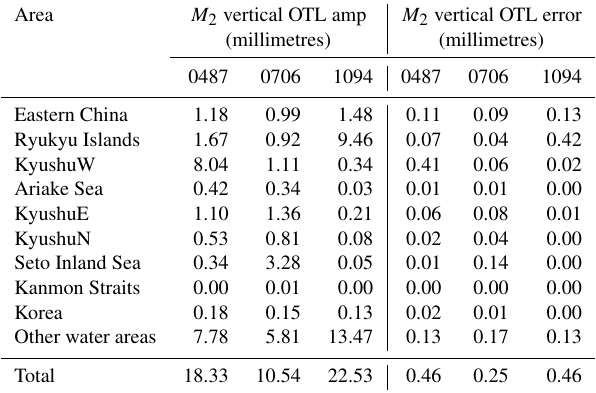
Table 3. The contribution of the defined water subareas in Fig. 2 to the M 2 vertical OTL displacement amplitudes and the resulting errors at GPS sites 0487, 0706, and 1094 according to Eq. (4), using the NAO99Jb model and its RMS